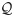
Locus of the trendline parameters (a, b) on the Cartesian plane, Q, for the Canberra distances dijC and the 11 countries analyzed, t ∈ [1960, 2015] and equal weights.The diameter and color of the circles are proportional to the value of R2. The dashed line delimits the clusters C1 and C2.